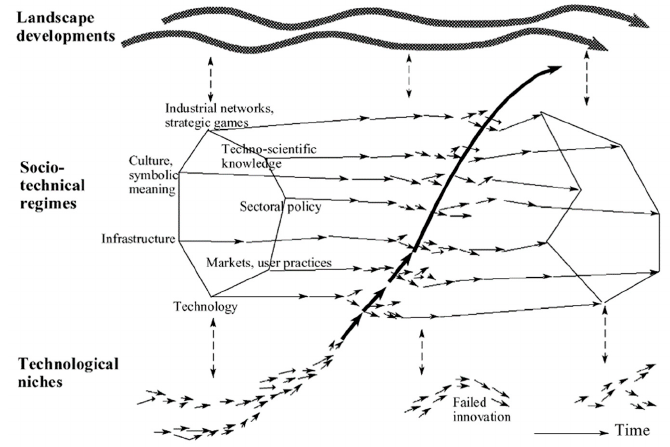
Figure 2. Multilevel social network coupling model [19].